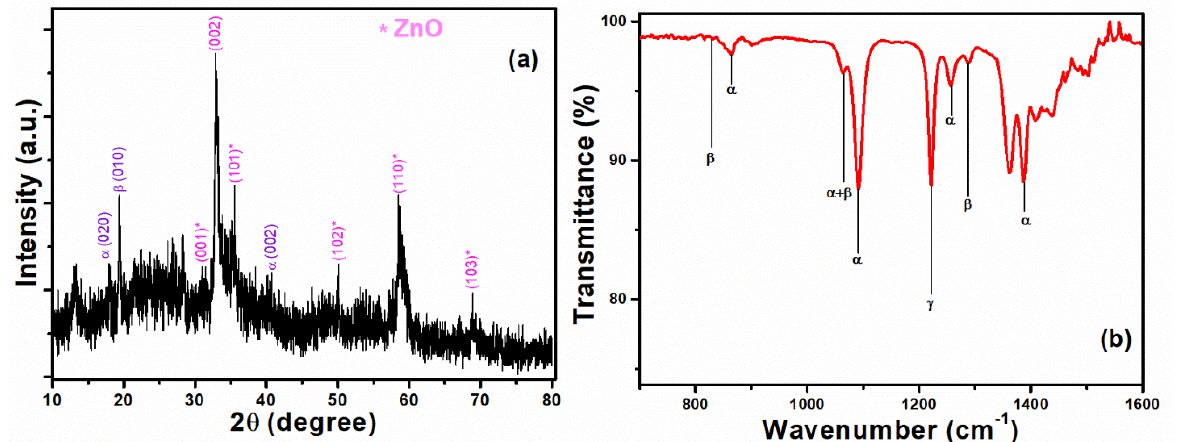
Figure 4. ( a ) XRD pattern of ZnO/PVDF composite, and ( b ) FTIR pattern labeled with α, β, and γ phases of PVDF.